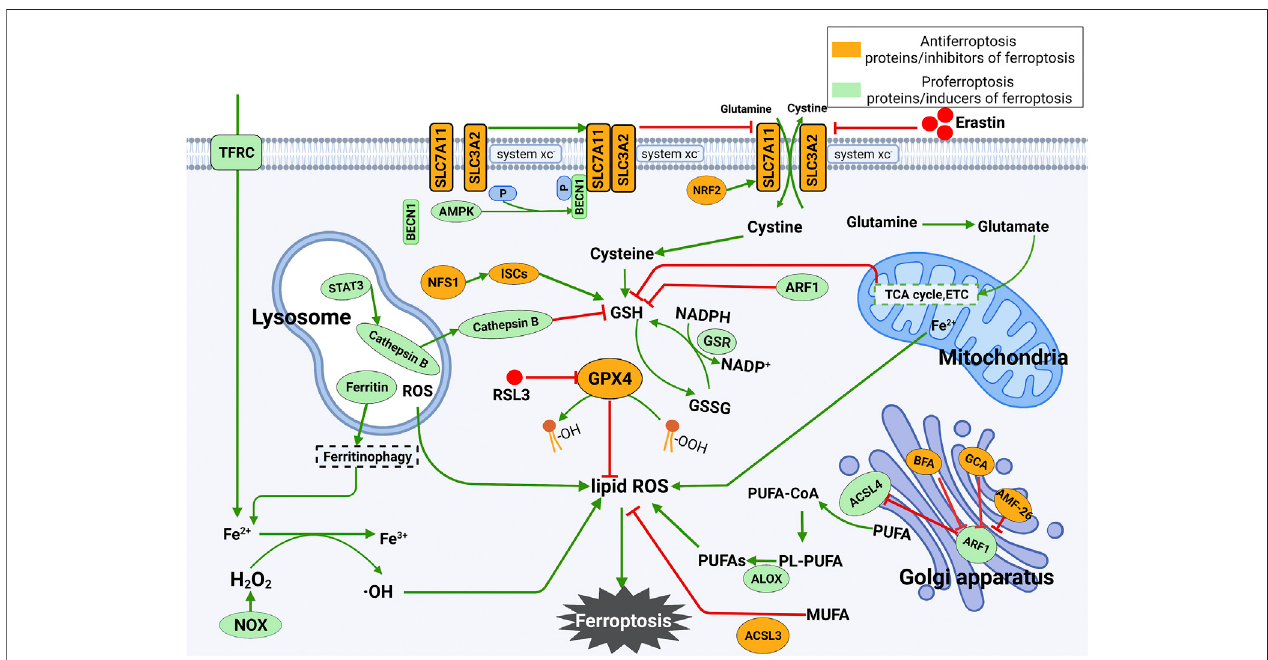
FIGURE 1 | Mechanism underlying the occurrence and regulation of ferroptosis. (1) Ferroptosis is mainly caused by lipid peroxidation. ROS leading to ferroptosis areproducedbytheiron-dependentFentonreaction,mitochondrialelectrontransportchainorNOXproteins.Ferroptosiscanbetriggeredbyenhancingthesynthesisof lipid ROS. (2) Inhibition of SLC7A11 deprives cells of cysteine, resulting in the loss of GSH and inactivation of GPX4. The latter further leads to the accumulation of lipid ROSand ferroptosis. The tricarboxylic acid cycle (TCA cycle) and electron carriers (ETC) in mitochondria stimulate GSH de fi ciency, thus leading toferroptosis. The releaseofFe 2+ inmitochondria increases thelevel offreeFe 2+ incellsand eventually promotes theproduction oflipid ROS.Lysosomal ROScontributetotheproduction of lipid ROS. In lysosomes, STAT3-mediated expression of cathepsin B is essential for ferroptosis via the MEK-ERK signaling pathway. In the Golgi apparatus, the Golgi stressresponsecaninhibitARF1,whichisaninhibitorofGSHandACSL4andanactivatorofSLC7A11.SilencingARF1promotesferroptosisbyincreasingcellularROS levels.